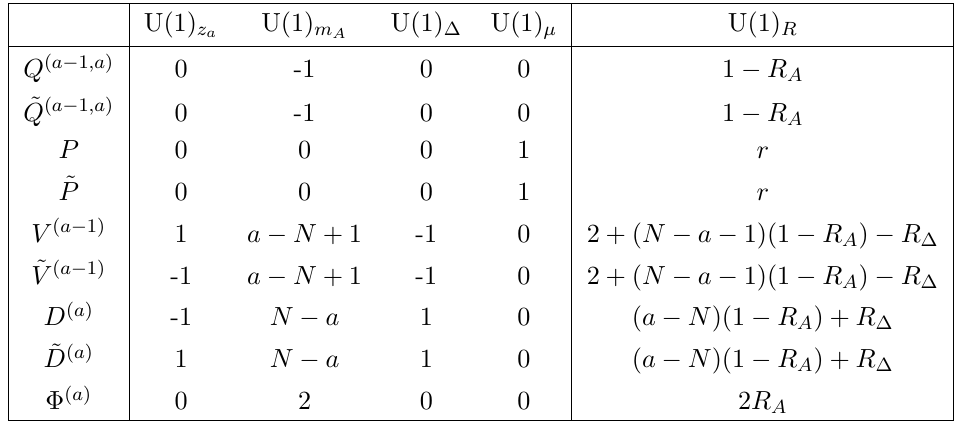
Table 2 . In the table, a runs from 1 to N . By de(cid:12)nition, Q (0 ; 1) = ~ Q (0 ; 1) = 0, V (0) = ~ V (0) = 0 and (cid:8) ( N ) =